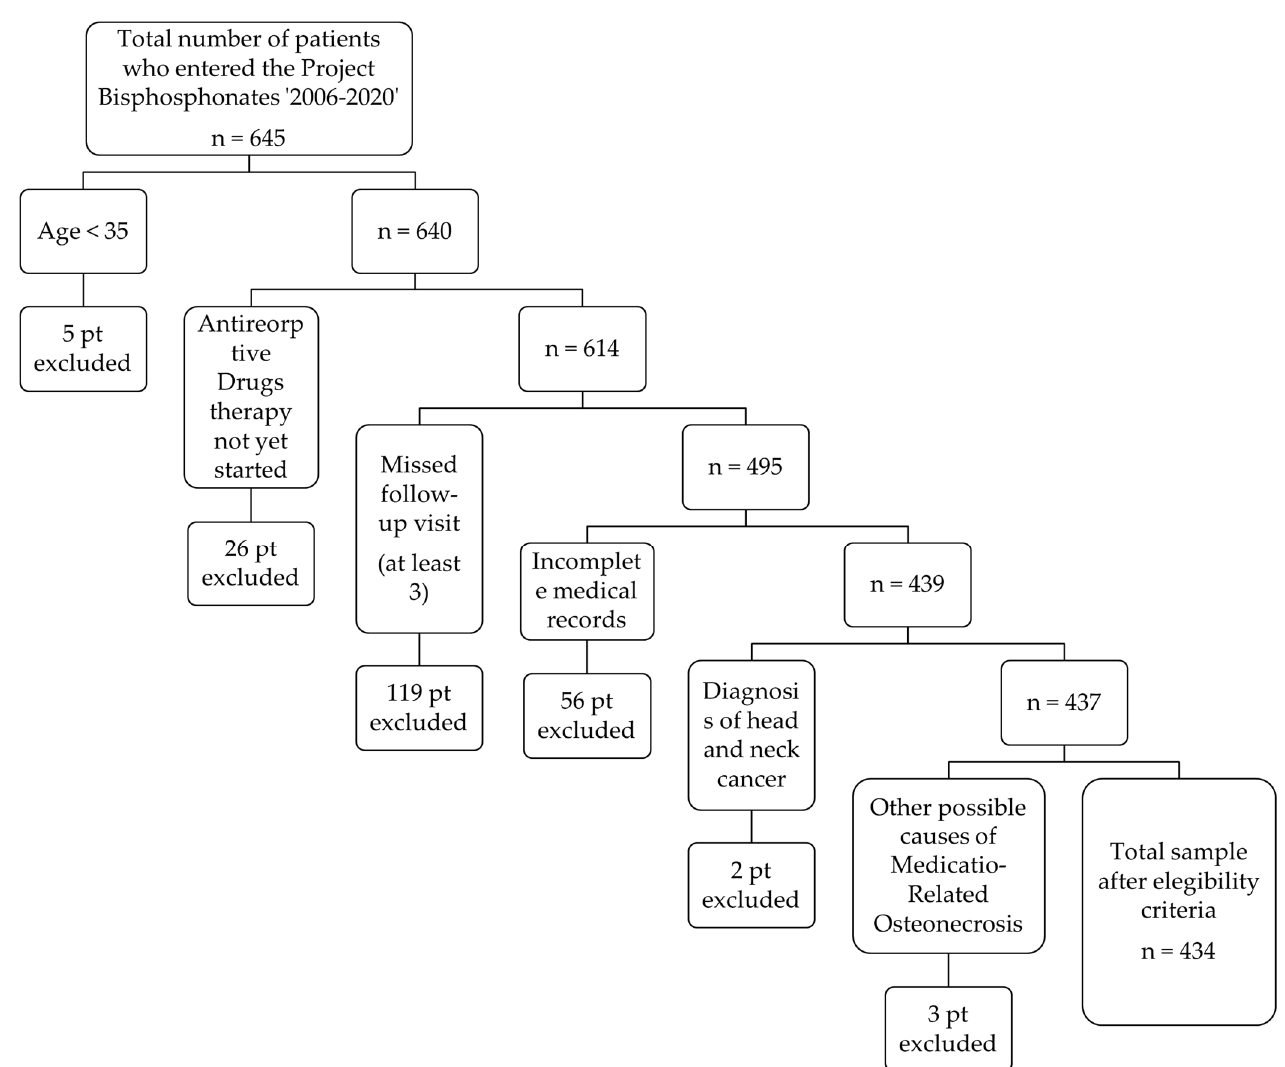
Figure 1. Workflow of patient selection.